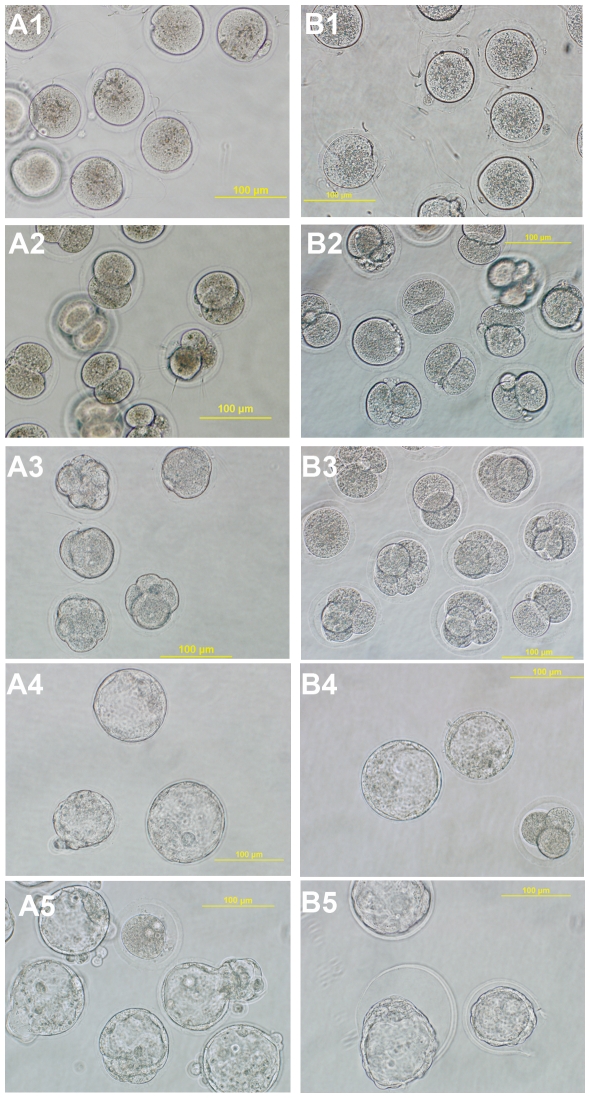
Following in vitro fertilization and culture, both fresh (A1) and vitrified oocytes in 0.1 M trehalose (B1) were capable of developing to the two-cell (A2; B2), four-cell (A3; B3) and blastocyst (A4; B4) stages, respectively.Furthermore, blastocysts were able to hatch (A5; B5) without chemical or mechanical assistance and some were used to derive embryonic stem cells.